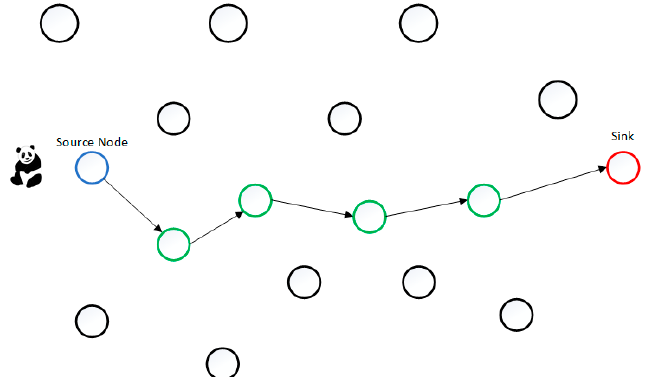
Figure 1. An example of the DAD Technique.